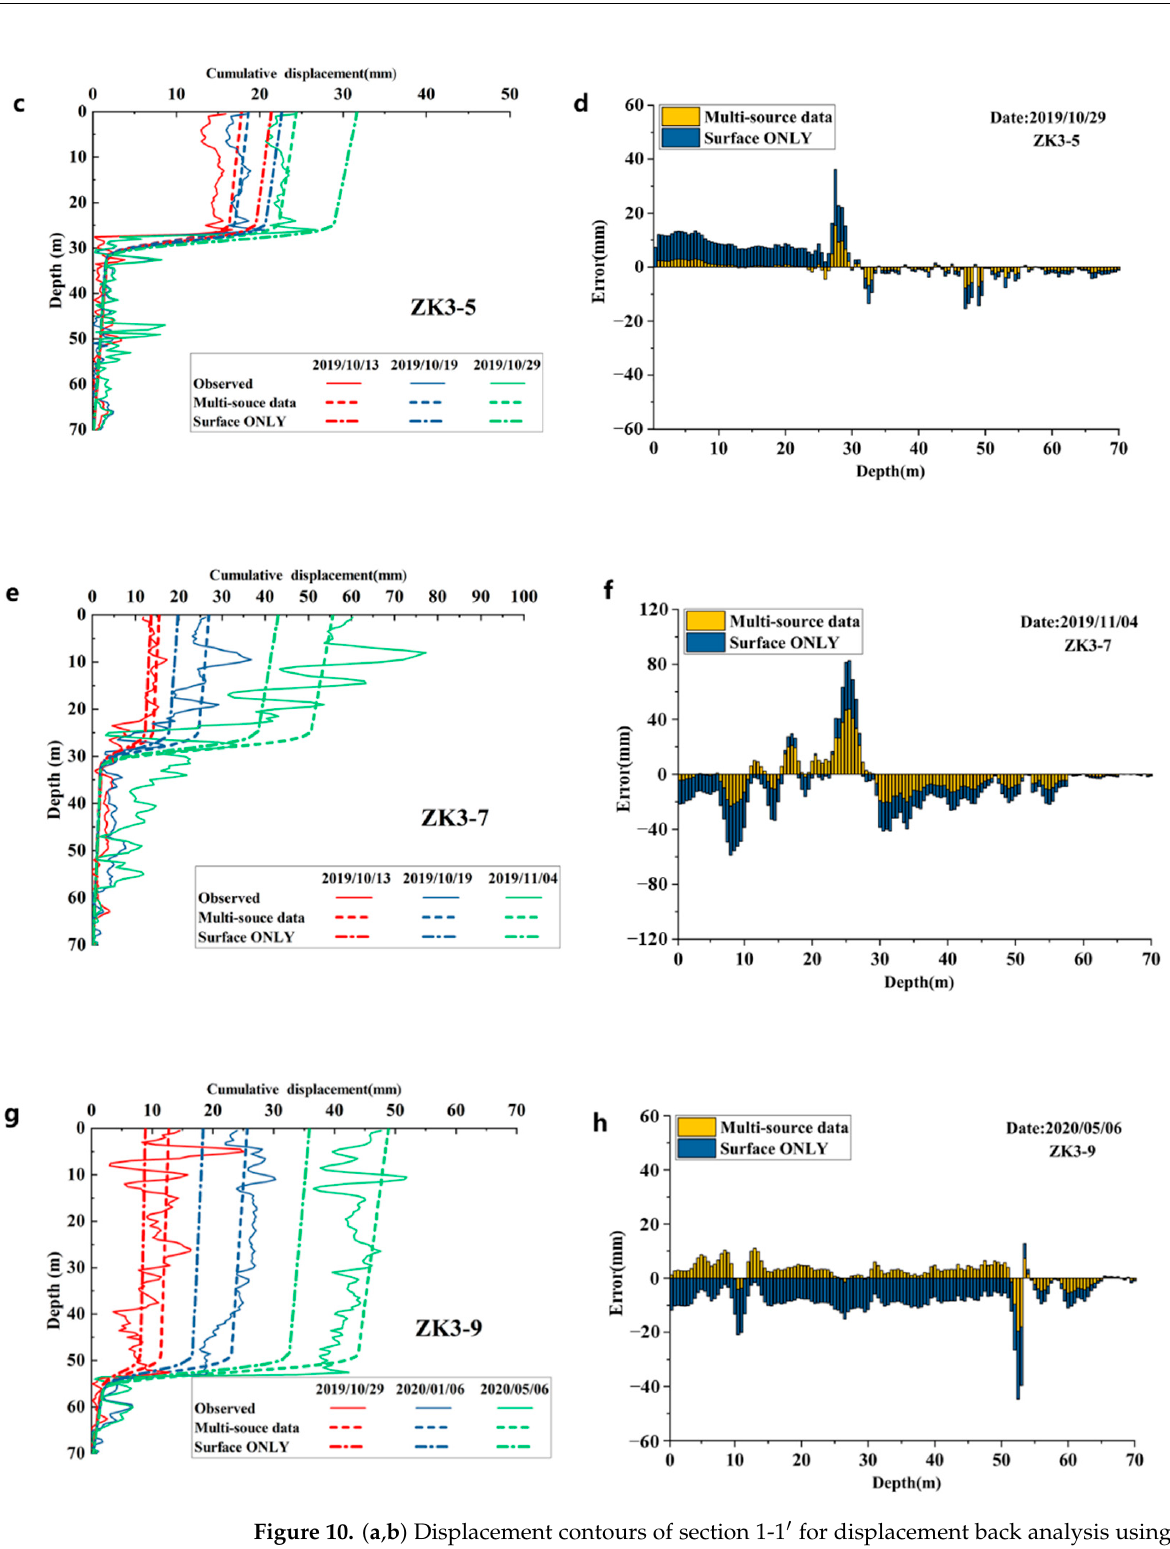
Figure 10. ( a , b ) Displacement contours of section 1-1 (cid:48) for displacement back analysis using multi- source and “Surface ONLY” monitoring data, respectively. ( c , e , g ) Comparisons of the simulated displacements along the boreholes ZK3-5, ZK3-7, and ZK3-9 with measured data. ( d , f , h ) Error distributions of the simulated displacements along with the borehole